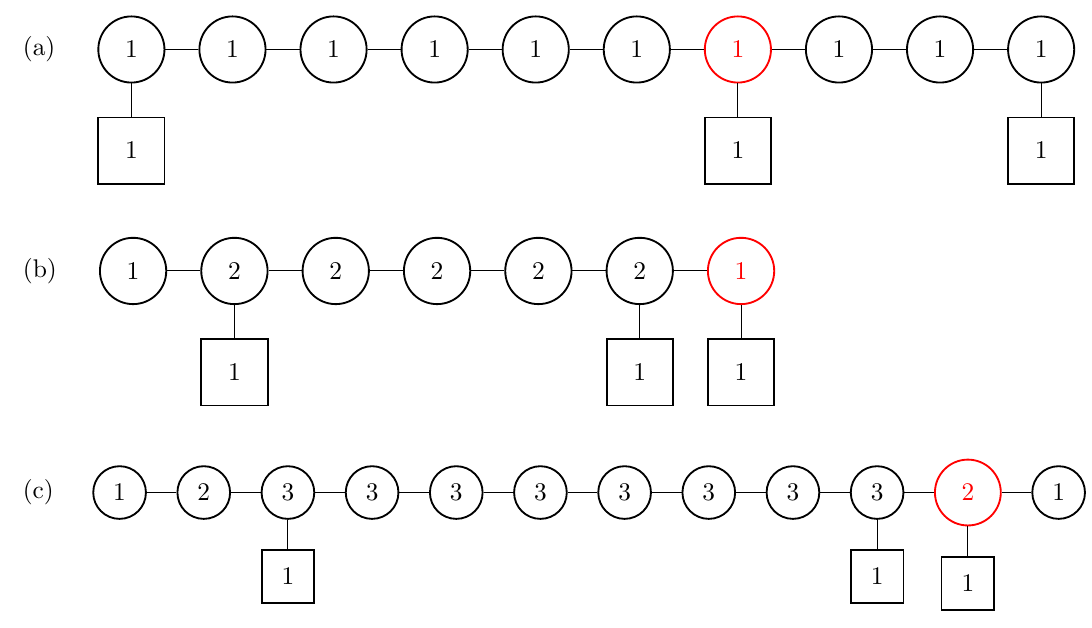
Figure 14 . Example of quiver SQMs in an SU(3) theory for (a) B = diag( (cid:0) 6 ; 1 ; 5) and v = diag( (cid:0) 5 ; 1 ; 4), (b) B = diag( (cid:0) 5 ; 2 ; 3) and v = diag( (cid:0) 3 ; 1 ; 2), and (c) B = diag( (cid:0) 8 ; 3 ; 5) and v = diag( (cid:0) 5 ; 2 ; 3). Each quiver consists of two superconformal sub-quivers separated by a single unbalanced gauge node, which is drawn in